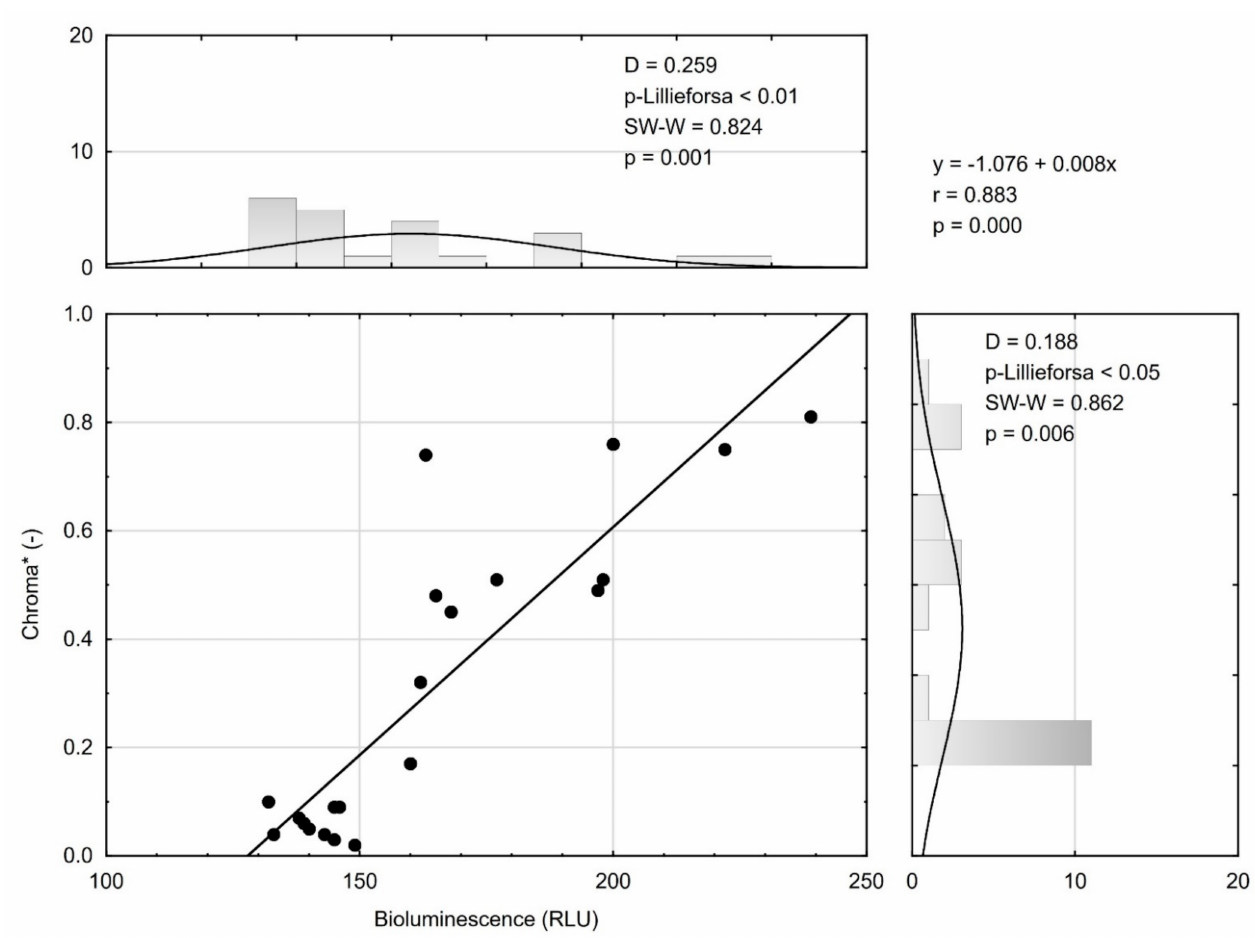
Figure 2. Relative probability of distribution of bioluminescence and chroma of mine waters despite the type of mine waters ( n = 22). SW - W, Shapiro - Wilk test; D, value of the test statistic Lilliefors